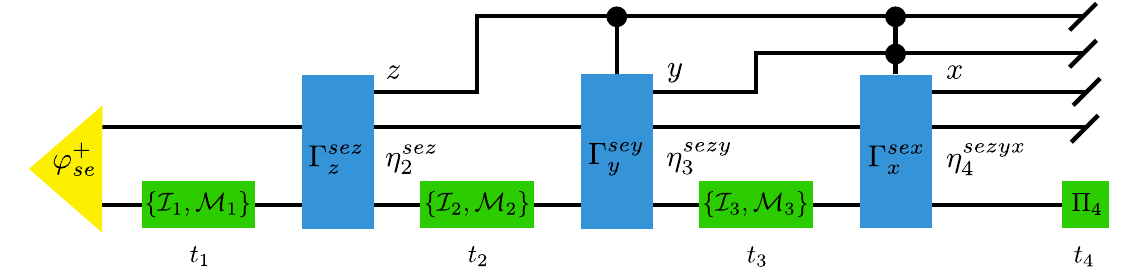
FIG. 15. Genuinely quantum process. The system and environment begin in a maximally entangled Bell state φ þ . As described in the se ; Γ sey y ; Γ sex text, the process dynamics consists of a sequence of maps, Γ sez , that either output φ þ or else bias the system in either the z , y , z x se or x basis, respectively [see Eqs. (I1) – (I3)]. The overall implementation of each of these maps is controlled on the joint state of all previous classical flag states z , y , x , which encode whether or not the system has already been biased. We show that this process is genuinely quantum by tracking the system-environment state throughout the dynamics, conditioned on whether the identity map I or an arbitrary CPTP map M was implemented at time t ; the labels η sez 2 ; η sezy 3 , and η sezyx 4 i i the interrogation at the relevant time [see Eqs. (I4), (I6), (I8), (I9), (I11), and (I12)]. In particular, we show that there does not exist a nonpathological POVM Π 4 that an experimenter can implement at t 4 such that the four sequences f I 1 ; I 2 ; I 3 g , f M 1 ; I 2 ; I 3 g , f I 1 ; M 2 ; I 3 g , and f I 1 ; I 2 ; M 3 g cannot be distinguished, thereby proving that the process is genuinely